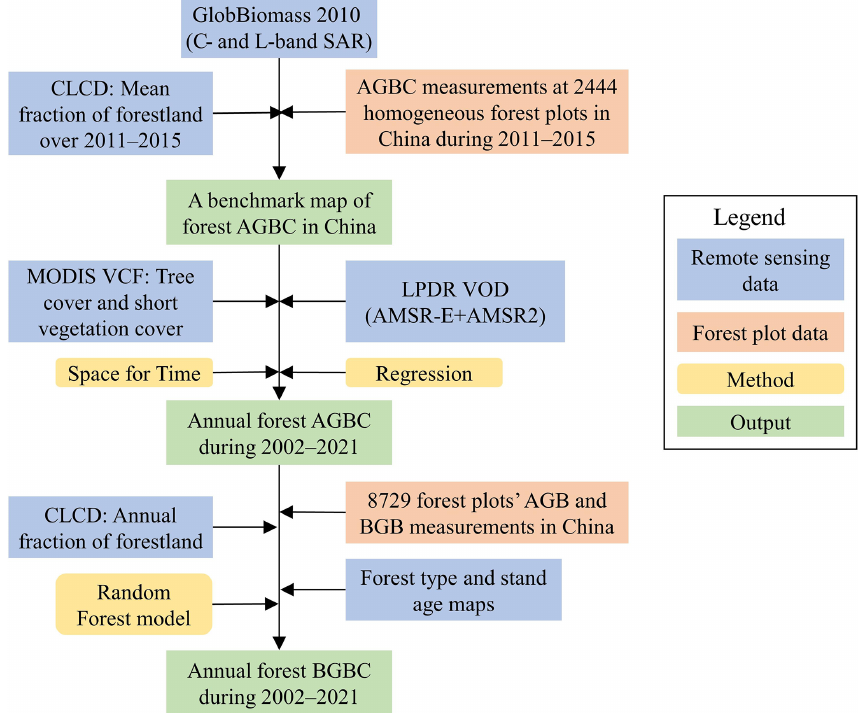
Figure 1. Workflow of forest biomass carbon pool monitoring in China during 2002–2021. AGBC and BGBC are the aboveground and belowground biomass carbon, VCF is the vegetation continuous field, LPDR VOD is the global land parameter data record vegetation optical depth, and CLCD is the China land cover